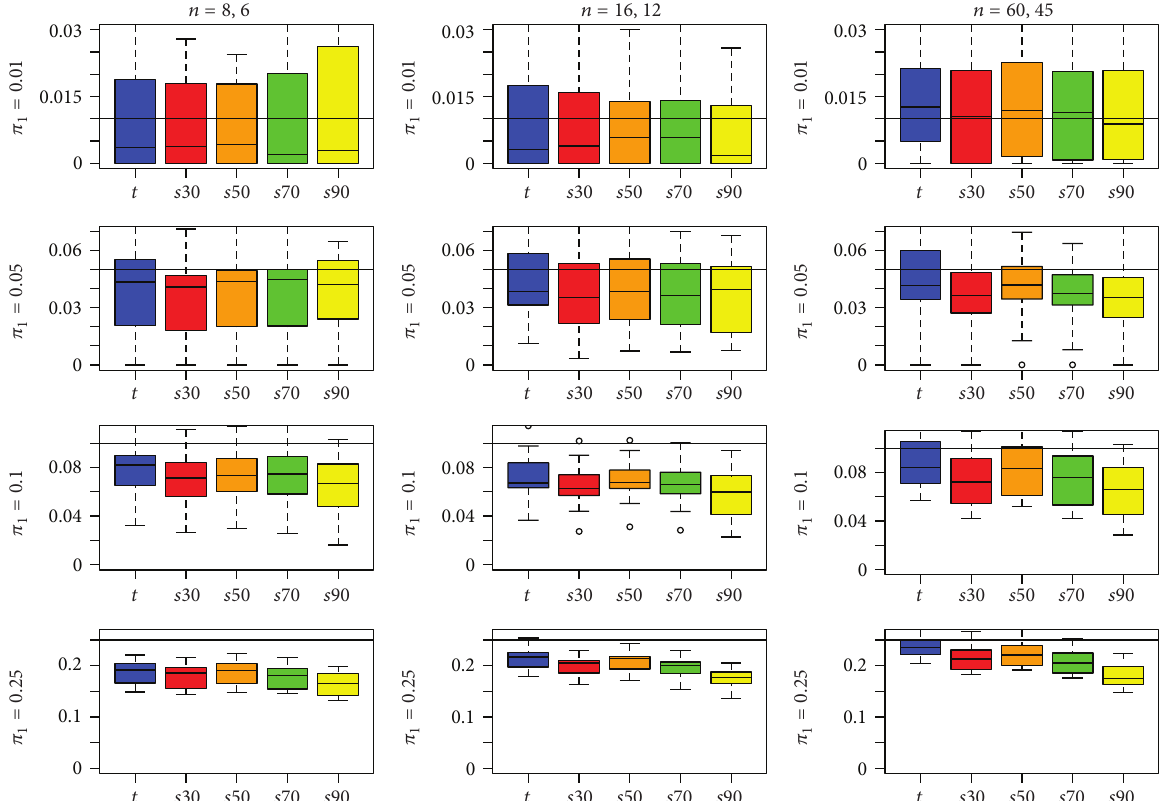
F 5: “ q value” estimates of proportion of differentially expressed